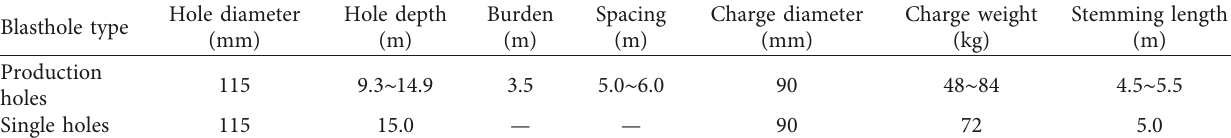
Table 5: Drill and blast parameters in the production blasting experiment.